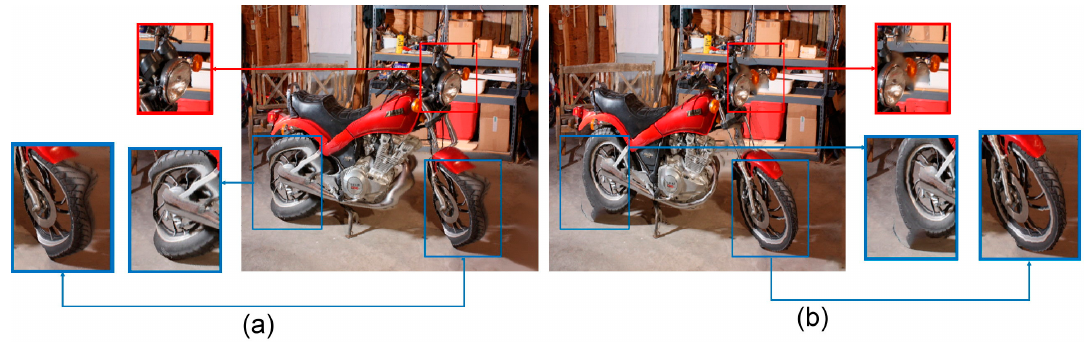
Figure 11. Comparison of the results obtained using ( a ) warping and ( b ) our model.